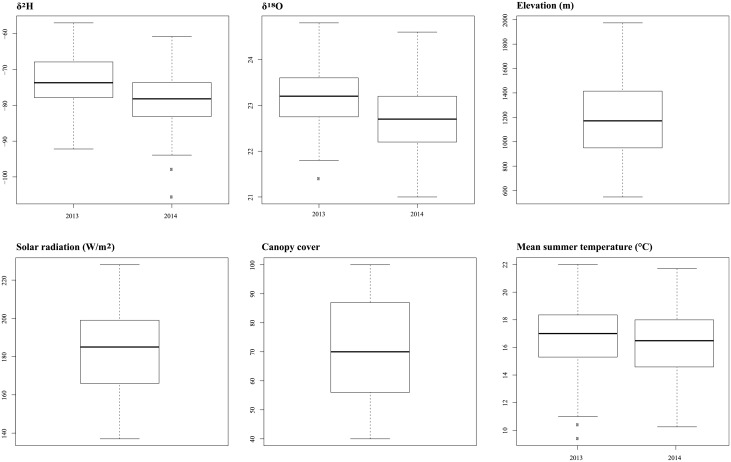
Box plots of δ18O and δ2H and the 4 candidate covariates.